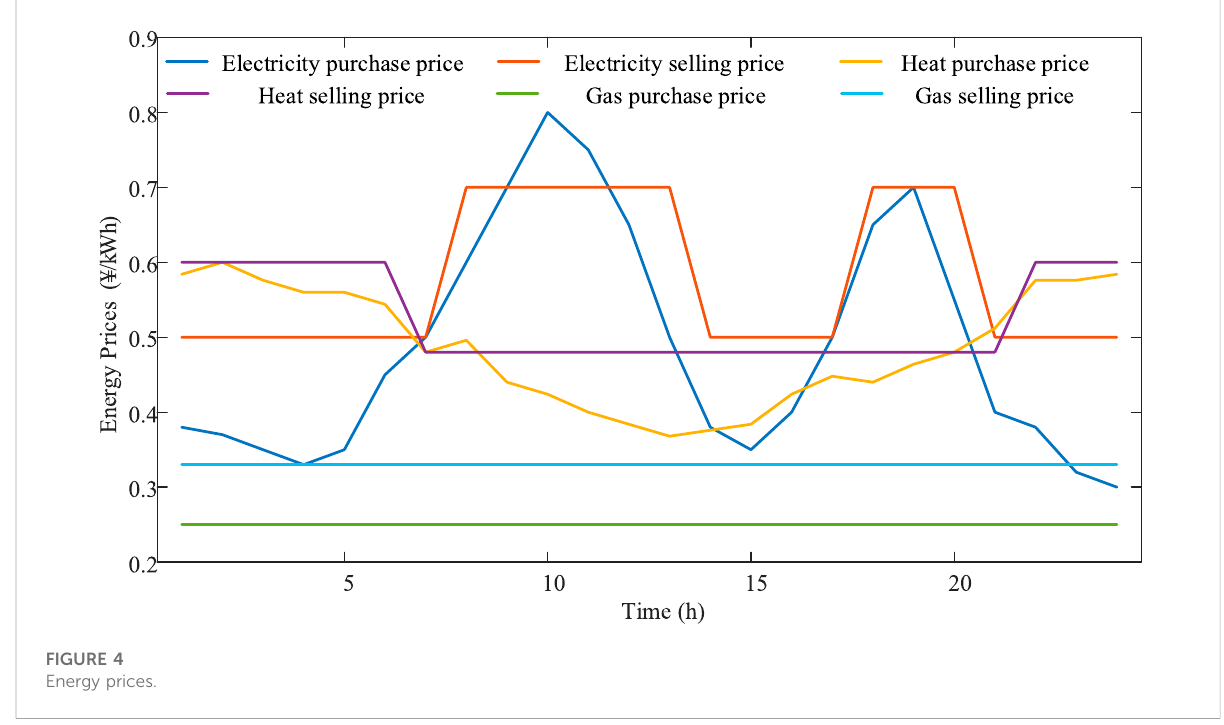
FIGURE 4 Energy